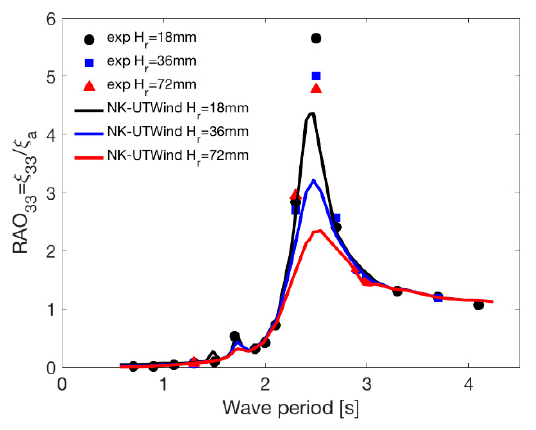
Figure 9. Response amplitude operator (RAO) heave motion result comparisons between the experiment and NK-UTWind numerical calculations for different wave heights.